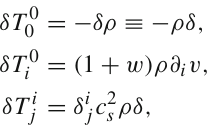
points behaves as unstable nodes in the positive triangle of the phase